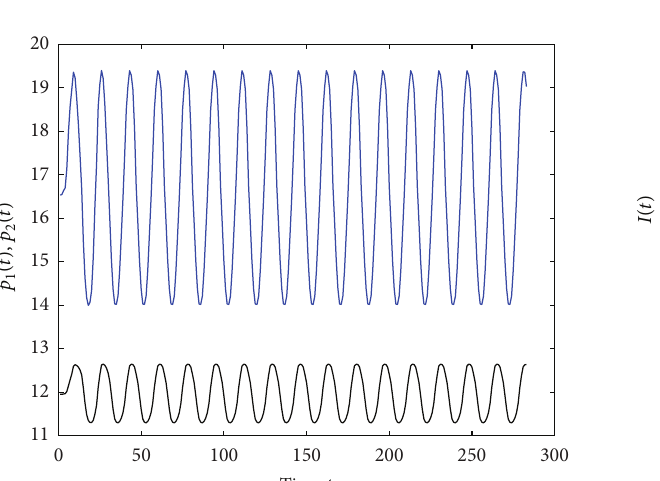
Figure 8: (𝑡,𝐼(𝑡)) , for 𝜏 < 𝜏 0